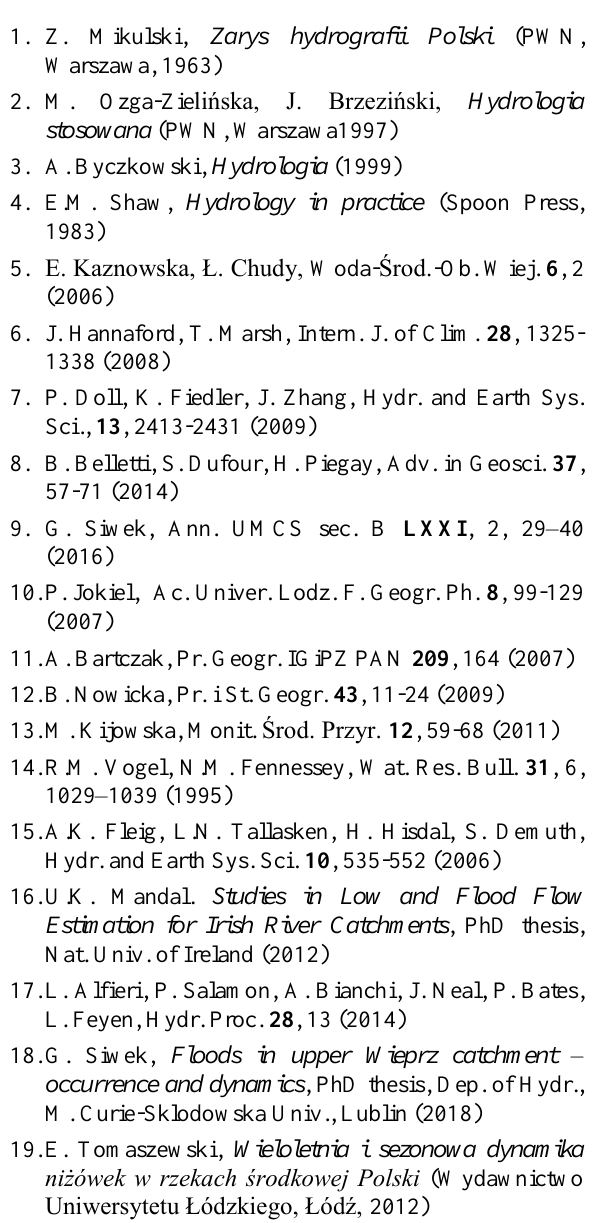
Table 2. Results of the normality test of the Shapiro-Wilk distribution and the non-parametric Mann-Kendall test on the trend, the significance level of